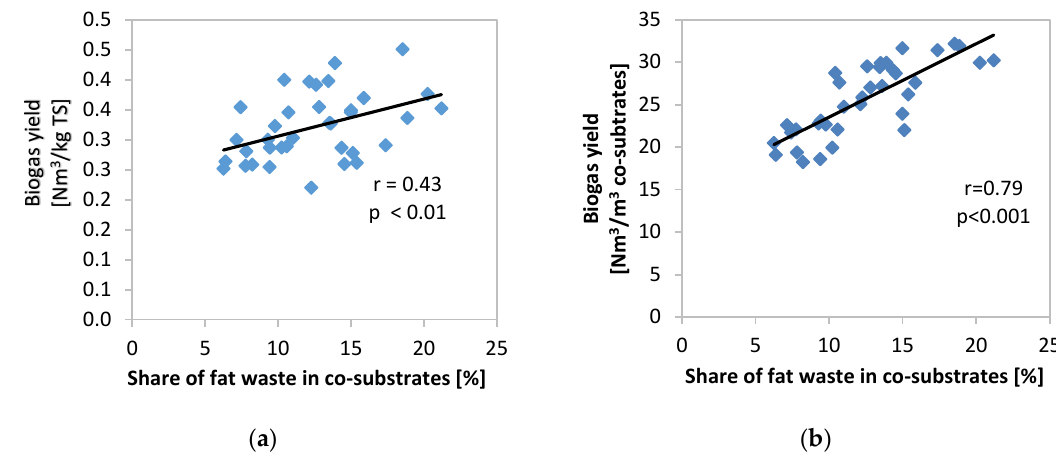
Figure 10. Influence of waste fat share in the digested mass on the biogas yield. Dependence between the share of waste fat and ( a ) biogas yield, ( b ) volumetric biogas yield.